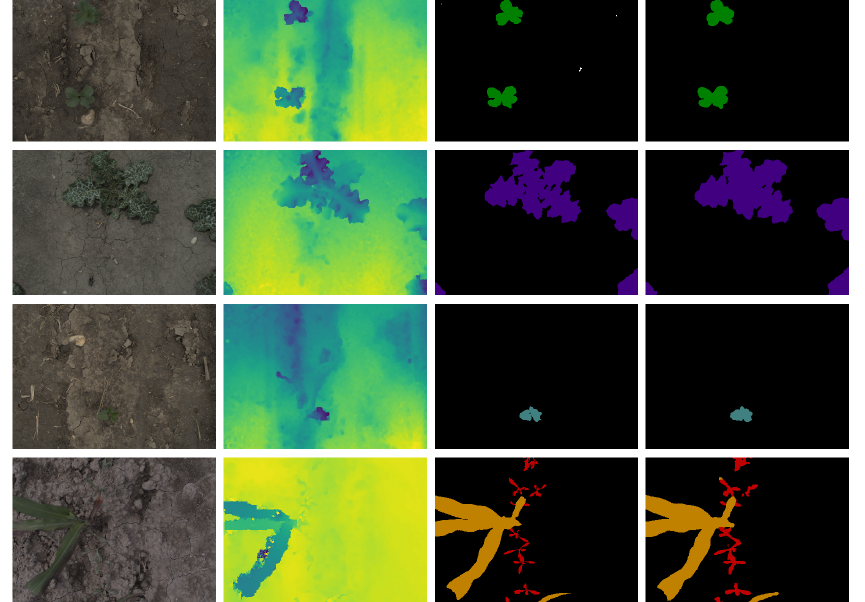
Figure 6. Inference of RGB-D semantic segmentation model trained on full-scale (1280 × 960 pixels) on four exemplary RGB-D images from the test set. Columns (from left to right ) show input RGB image, input distance map with nearest neighbor interpolation, ground-truth annotation and prediction of the trained model. Rows (from top to bottom ) show images taken in broad bean, milk thistle, soybean and combined corn and cornflower parcel. Color codes of the segmentation masks (ground-truth and prediction) correspond to those given in Figure 4, white pixels belong to a void class that was ignored in training and